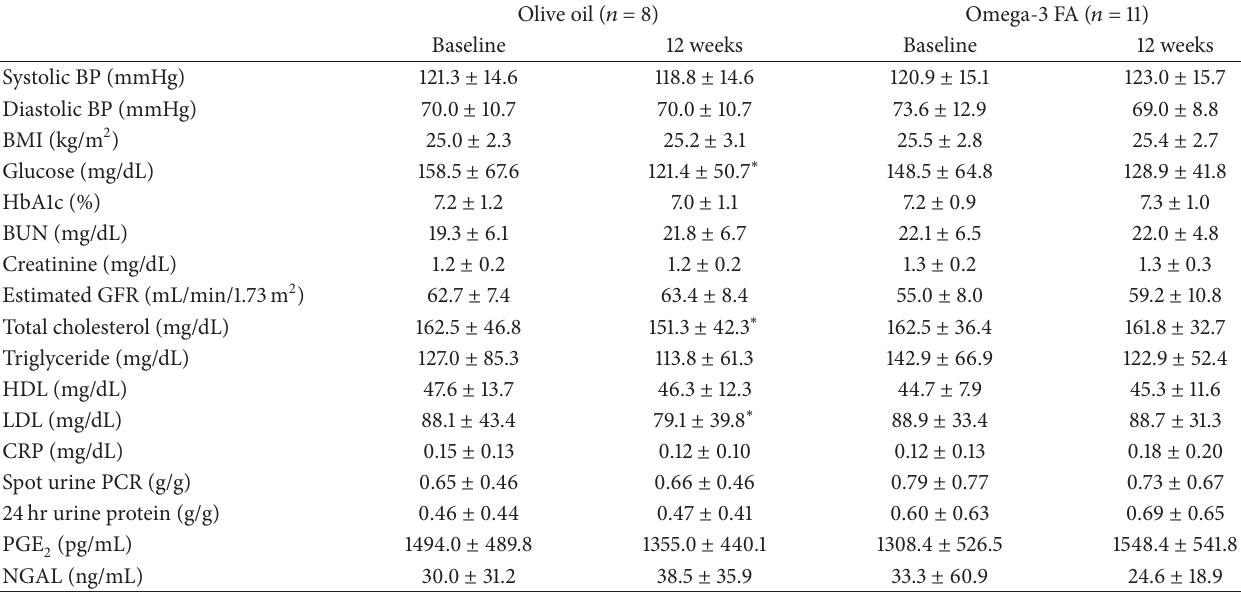
Table 4: Changes in biochemical